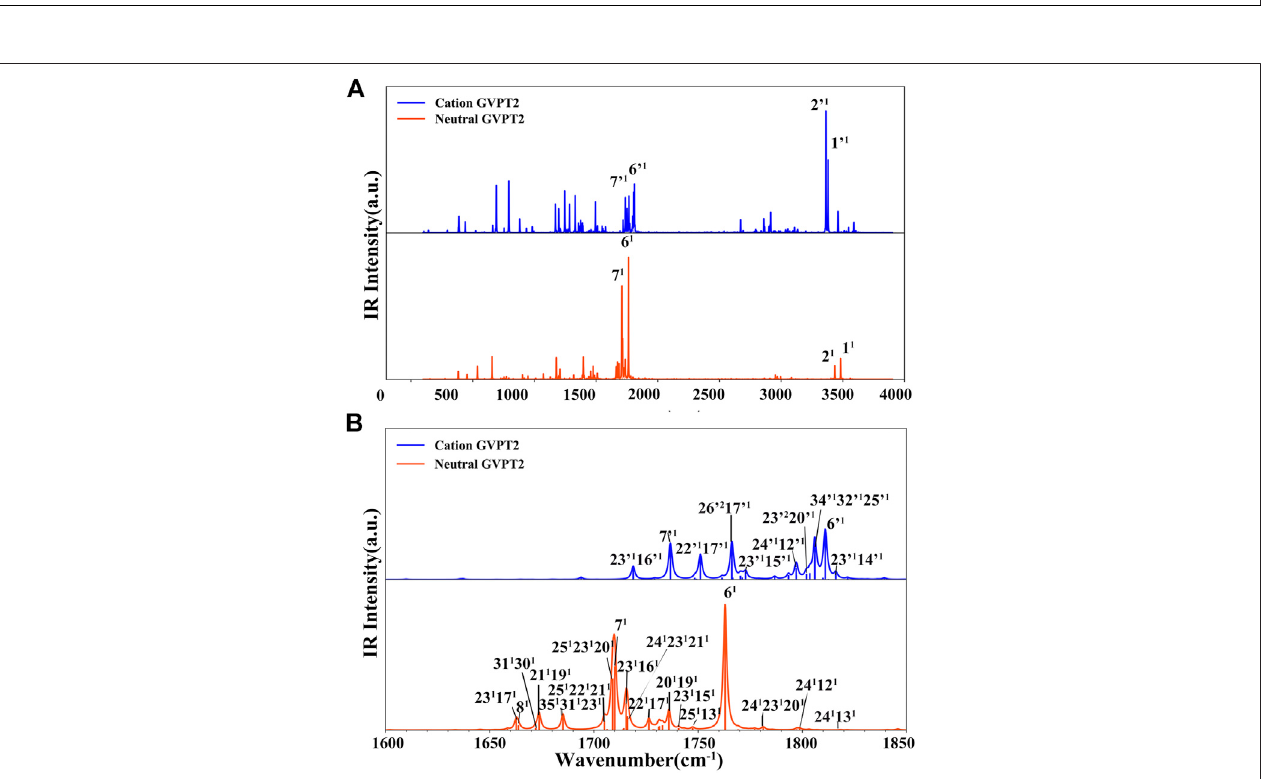
FIGURE 6 | MIR spectra simulated at GVPT2//B2PLYP//B3LYP/AVTZ level. Spectra line-shapes were broadened by Lorentzian functions with HWHM of 1 cm − 1 . (A) 100 cm − 1 - 4000 cm − 1 range (B) The 1600 cm − 1 -1850 cm − 1 range related to the modes 6, 7 and the non-fundamentals involved in the Fermi resonances. Most intense bands are assigned as m n where m is normal mode and n number of quanta (1 fundamentals, 2 overtones).